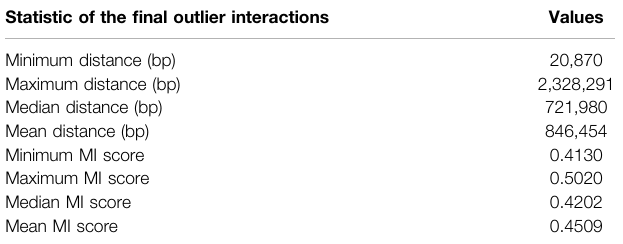
TABLE 1 | Statistics of the distance between positions of the two interacting polymorphic loci and statistics of the MI scores, both for the fi nal outlier interactions.